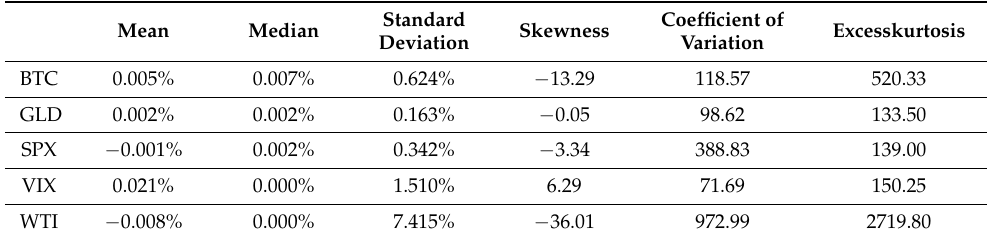
Table 1. Descriptive